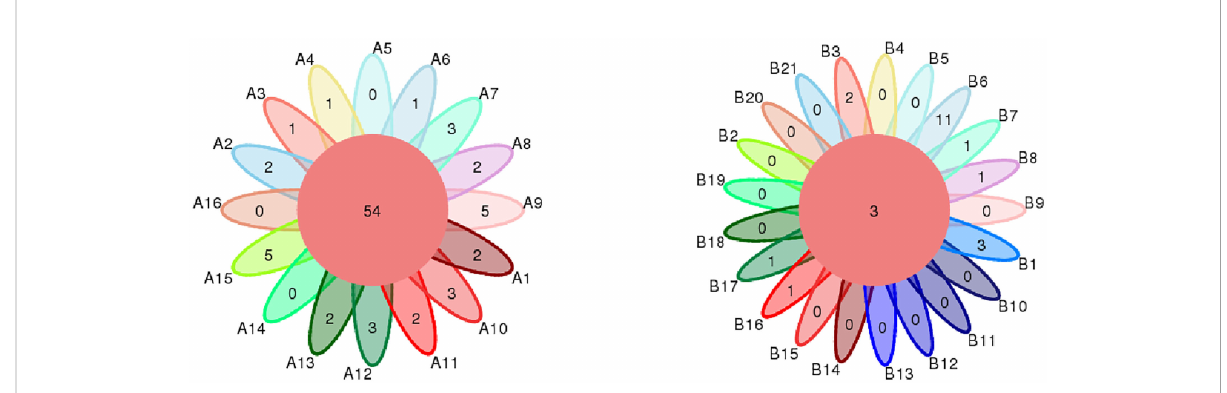
FIGURE 2 Comparison of mutual OTUs of samples from LRTI children with/without hematological malignancies. The left fi gure re fl ects BALF samples of LRTI children with hematological malignancies (Group A); the right fi gure re fl ects BALF samples of LRTI children without hematological